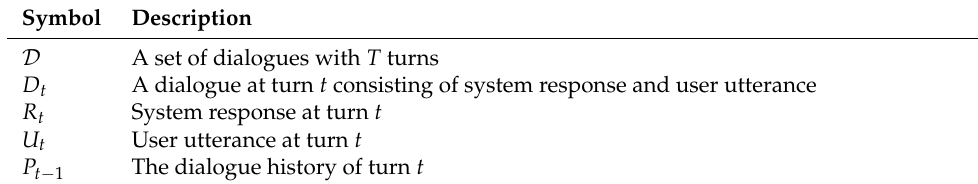
Table A1. Description of symbols in this